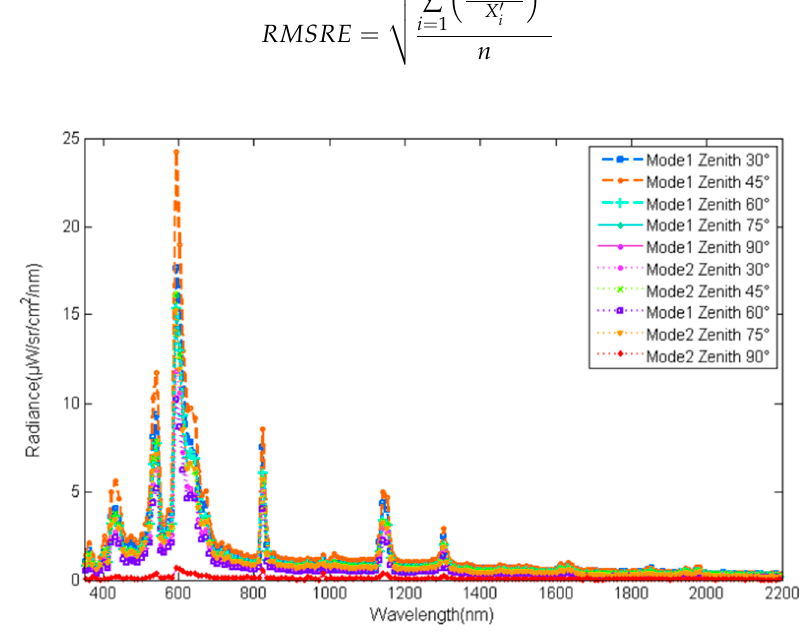
Figure 8. The spectral irradiance contributed by different zenith regions. Table 8. The irradiance of different modes. Table 9. The irradiance of different